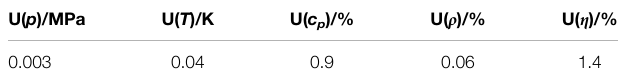
TABLE 1 | Uncertainties of the